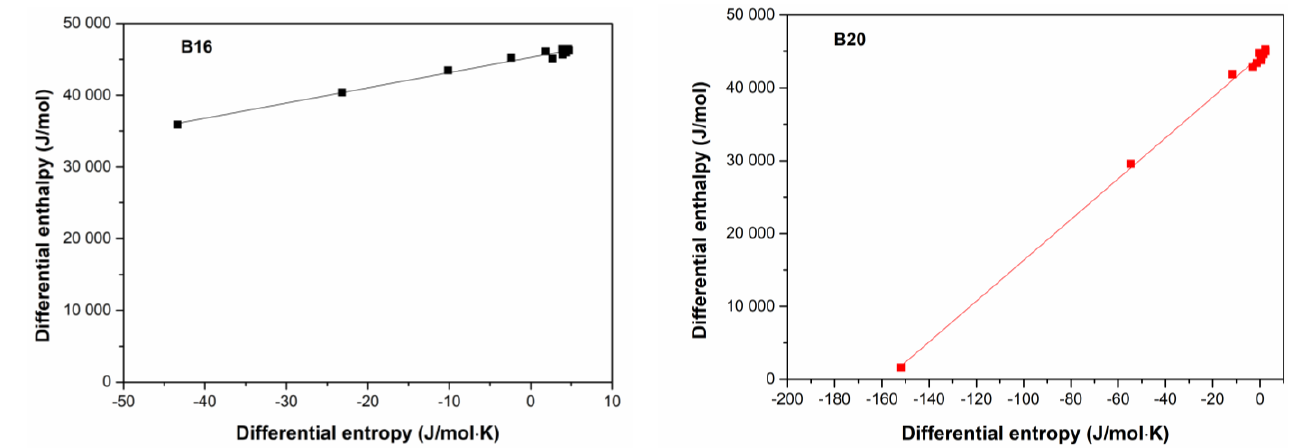
Figure 5. Enthalpy–entropy compensation plots for B16 and B20.